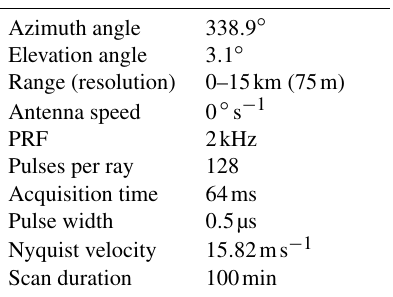
Table 4. Scan parameters of the fixed-pointing mode of the weather radar in